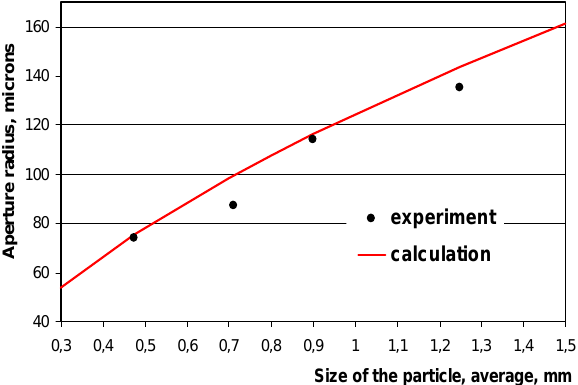
Figure 4. Relation between aperture radius and NaCl particle size ( P = 25